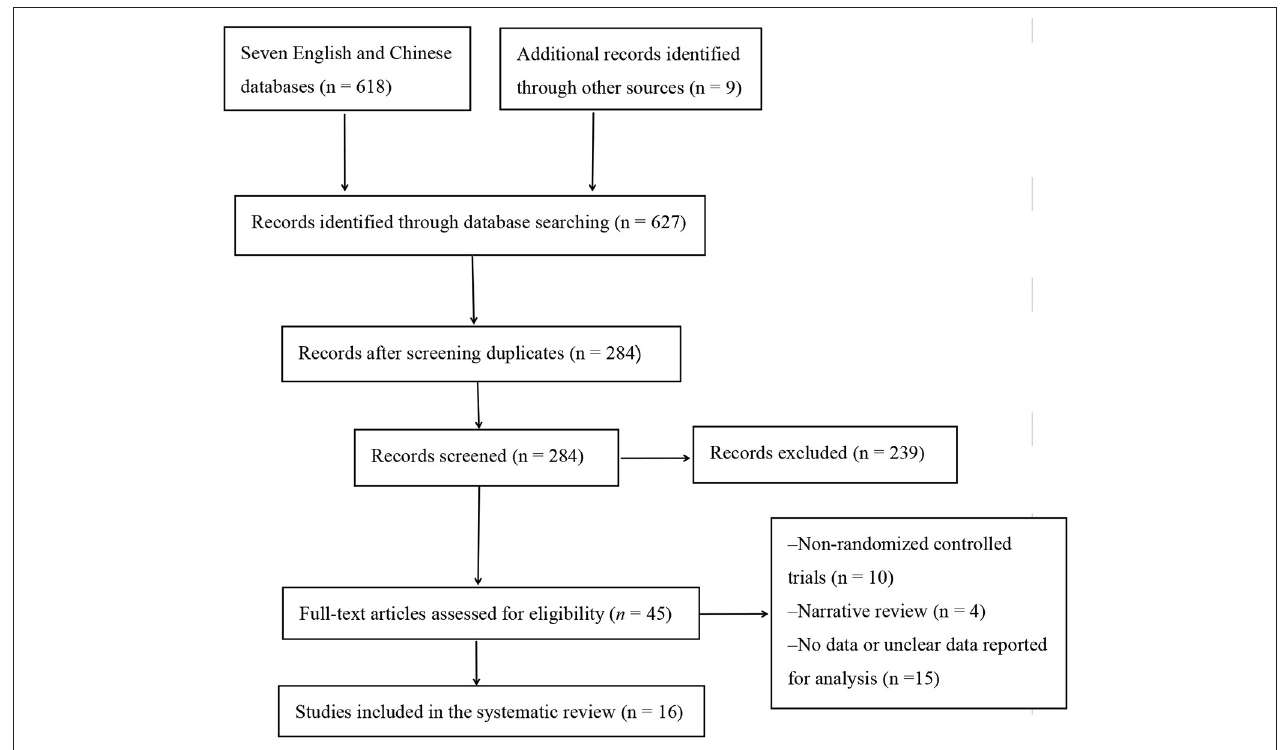
FIGURE 1 | Flow chart of study